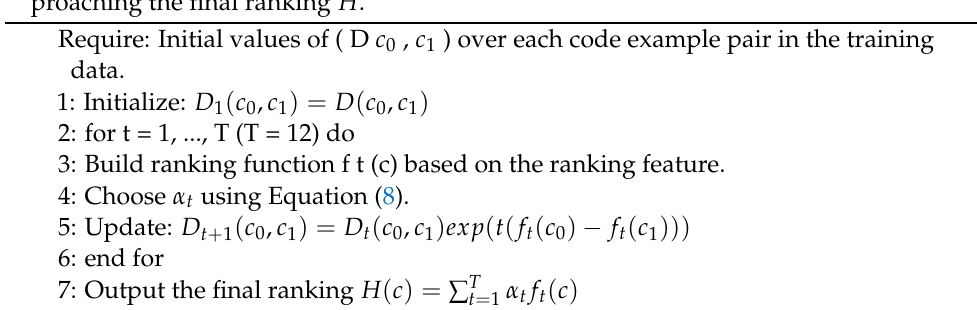
Algorithm 1: The learning process details of the RankBoot algorithm for ap- proaching the final ranking H